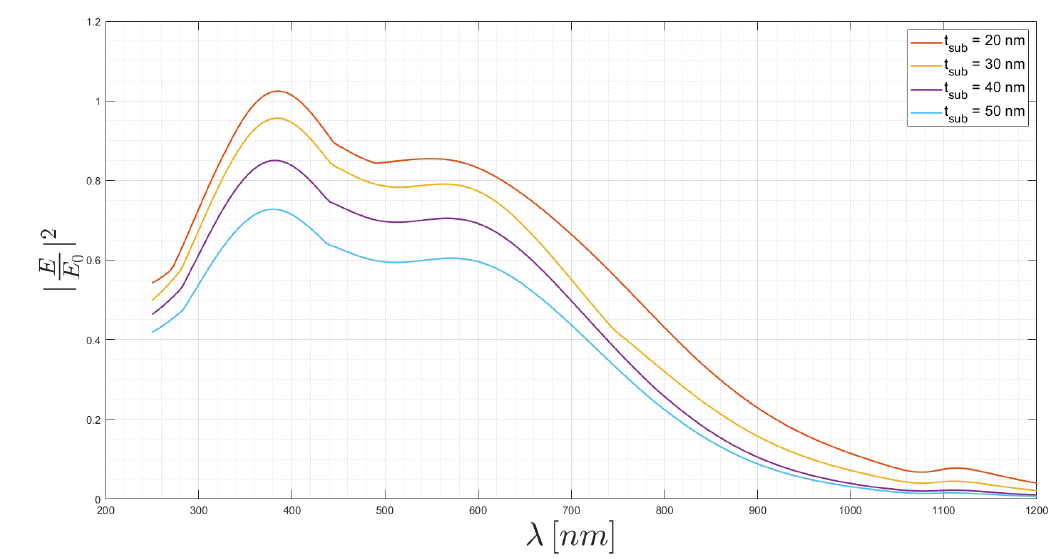
Figure 10. Substrate thickness sweep on an aluminum nanostructure with a quartz